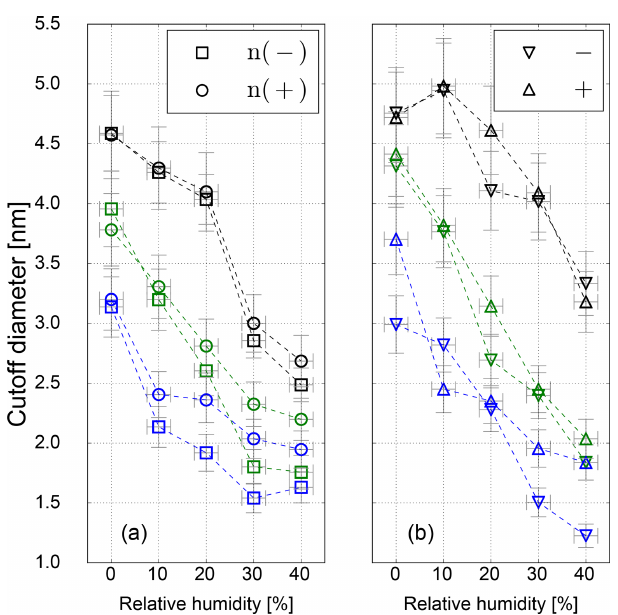
Figure 6. Cutoff diameter as a function of RH for neutral (a) and charged (b) sodium chloride seeds for low- (blue), standard- (green) and high-temperature (black)